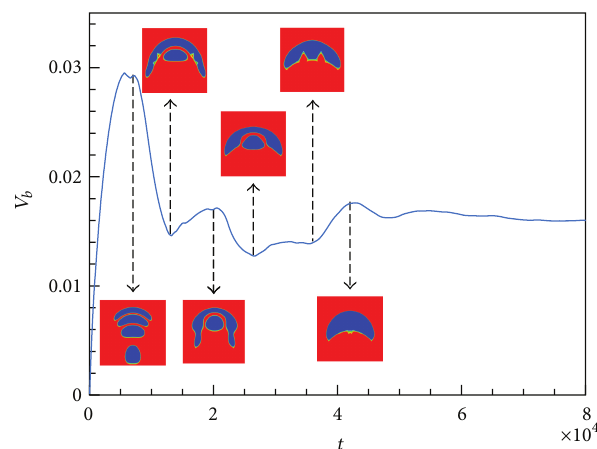
Figure 8: Time evolution of the rising velocity of four bubbles for Eo = 8 .